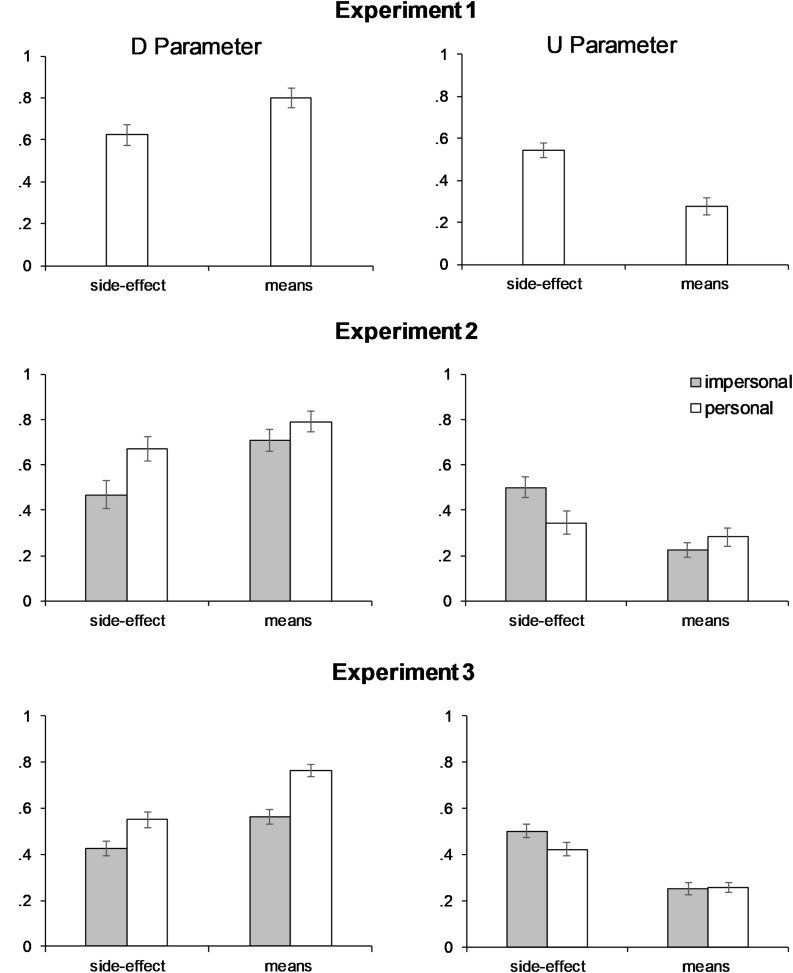
Means of the PD Deontology and Utilitarianism parameters in Experiments 1-3. Error bars indicate the standard error of the mean.